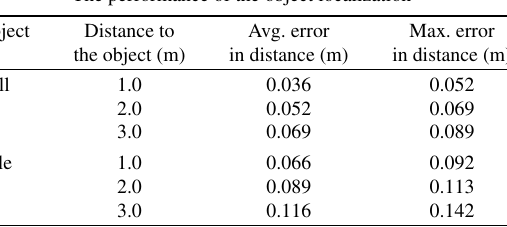
Table 2 The performance of the object